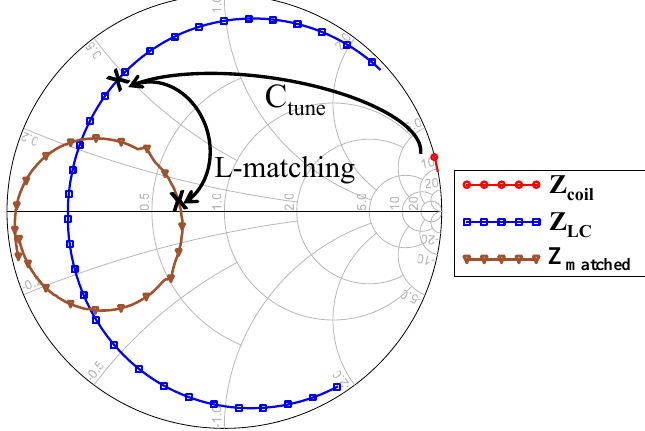
Figure 6. Smith chart plot showing the measured coils input impedance at different matching stages: (1) coil’s inductive impedance, (2) resonant coil using C-tuning, (3) impedance-matched radiating